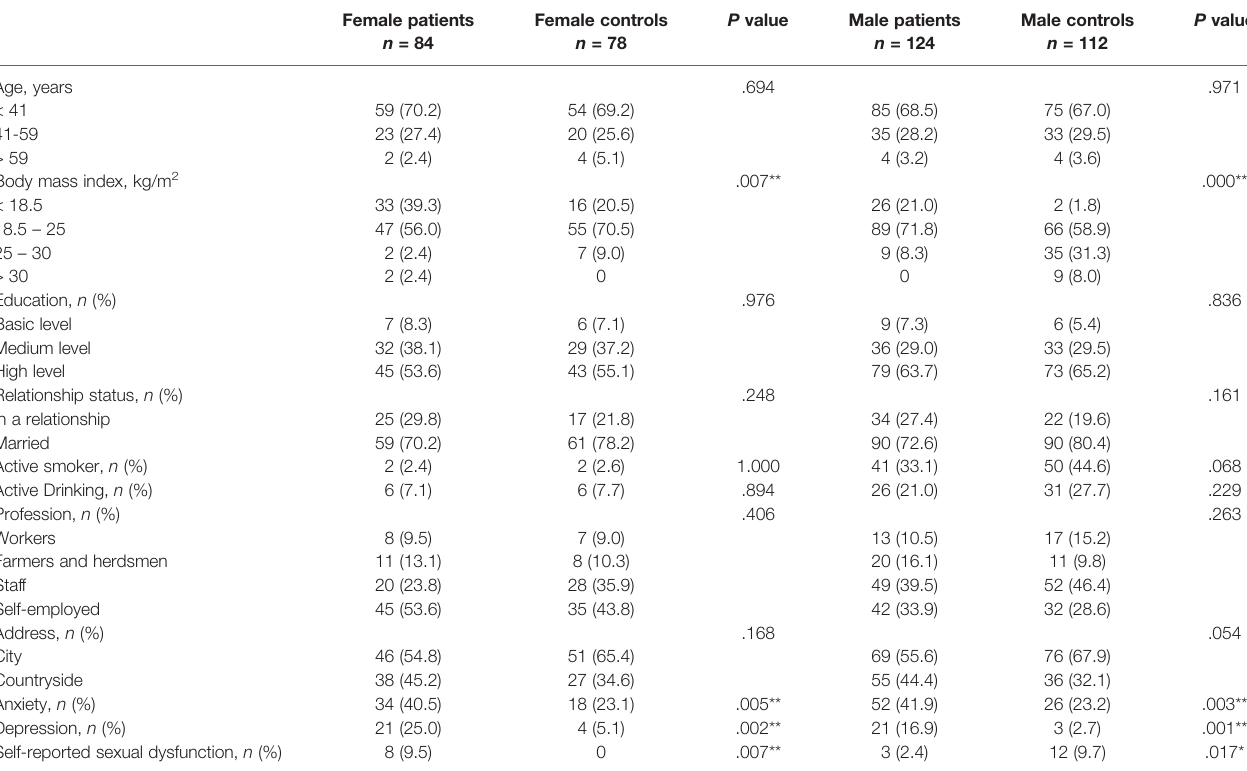
TABLE 1 | Participants characteristics.